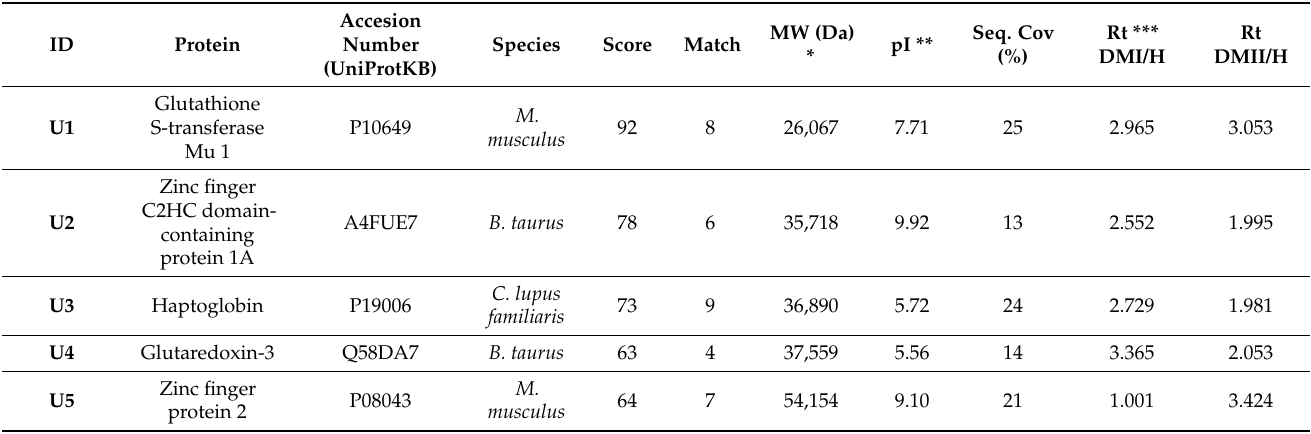
Table 2. Significantly ( p ≤ 0.05) differentially expressed proteins in diabetic dogs identified by MALDI-TOF MS.